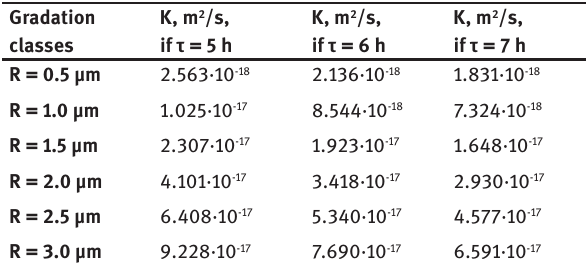
Table 4: Input data for the dispersion analysis. Gradation